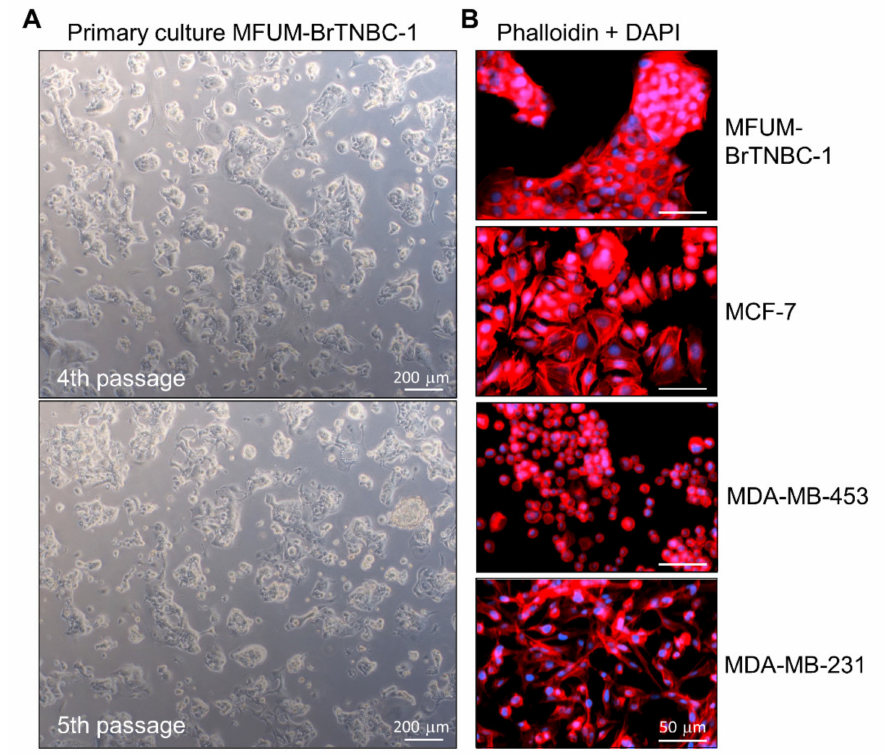
Figure 2. Morphological characteristics of MFUM-BrTNBC-1 CL. Legend: ( A ) The primary MFUM- BrTNBC-1 culture; 4th passage (upper), 5th passage (lower). Images were taken at × 50 magnification on Zeiss Axiovert 40 inverted microscope. Scale bar = 200 µ m ( B ) Immunofluorescence images of actin filaments (red) and nuclei (blue) showing cell morphology of MFUM-BrTNBC-1, MCF-7, MDA-MB-453 and MDA-MB-231 (cells were stained by using fluorescent phalloidin conjugate for actin and DAPI for nuclei). Immunofluorescence staining was carried out in triplicate for all CLs, and representative images are shown. Images were taken at × 10 magnification on EVOS FL fluorescence microscope). Scale bar = 50 µ